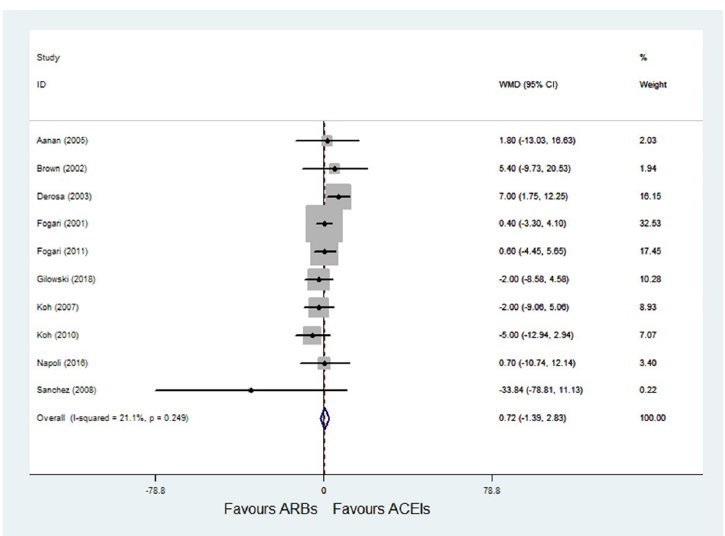
Fig 4. Effect of ARBs versus ACE inhibitors on fasting plasma glucose.